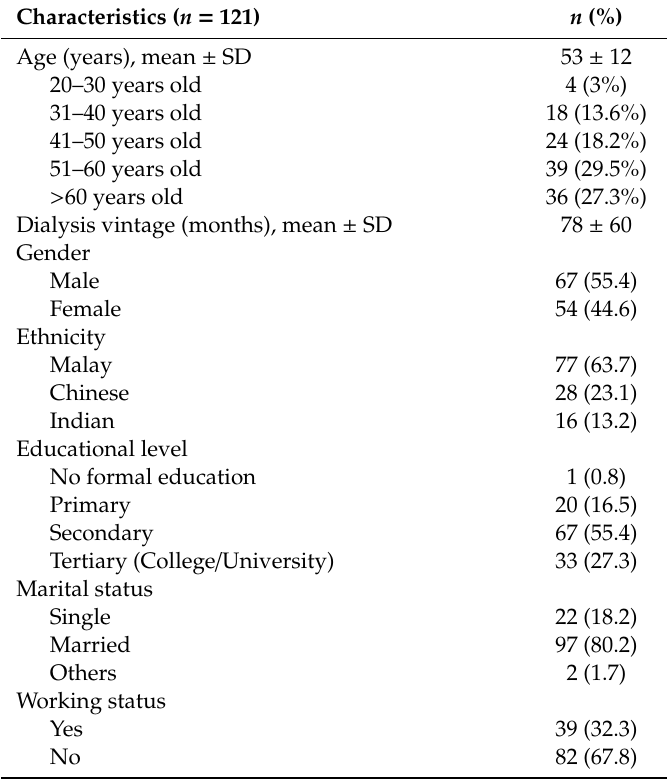
Table 2. Sociodemographic characteristics of Phase III